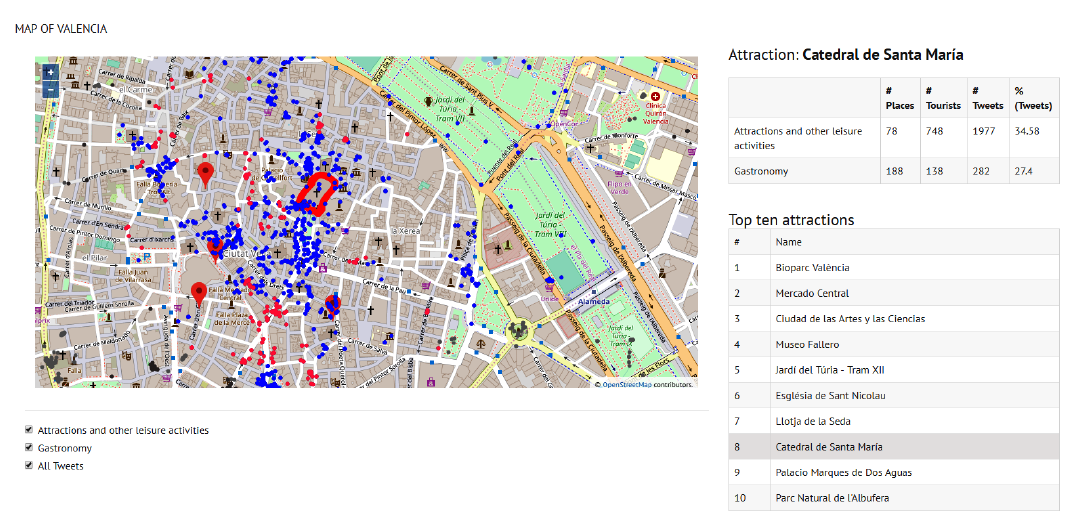
Figure 11. Zoom in on Catedral de Santa Maria (site